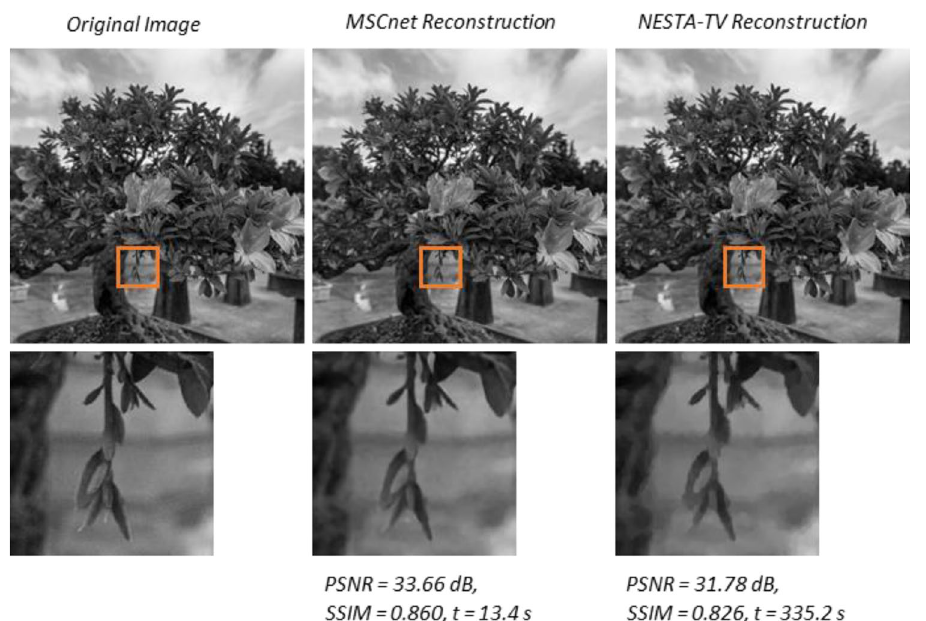
Figure 4. Comparison between a 2048 by 2048 image (top left) and the image reconstruction out of M/N = 0.03 compressive samples with the proposed CMSnet (top center) and the iterative NESTA-TV (top